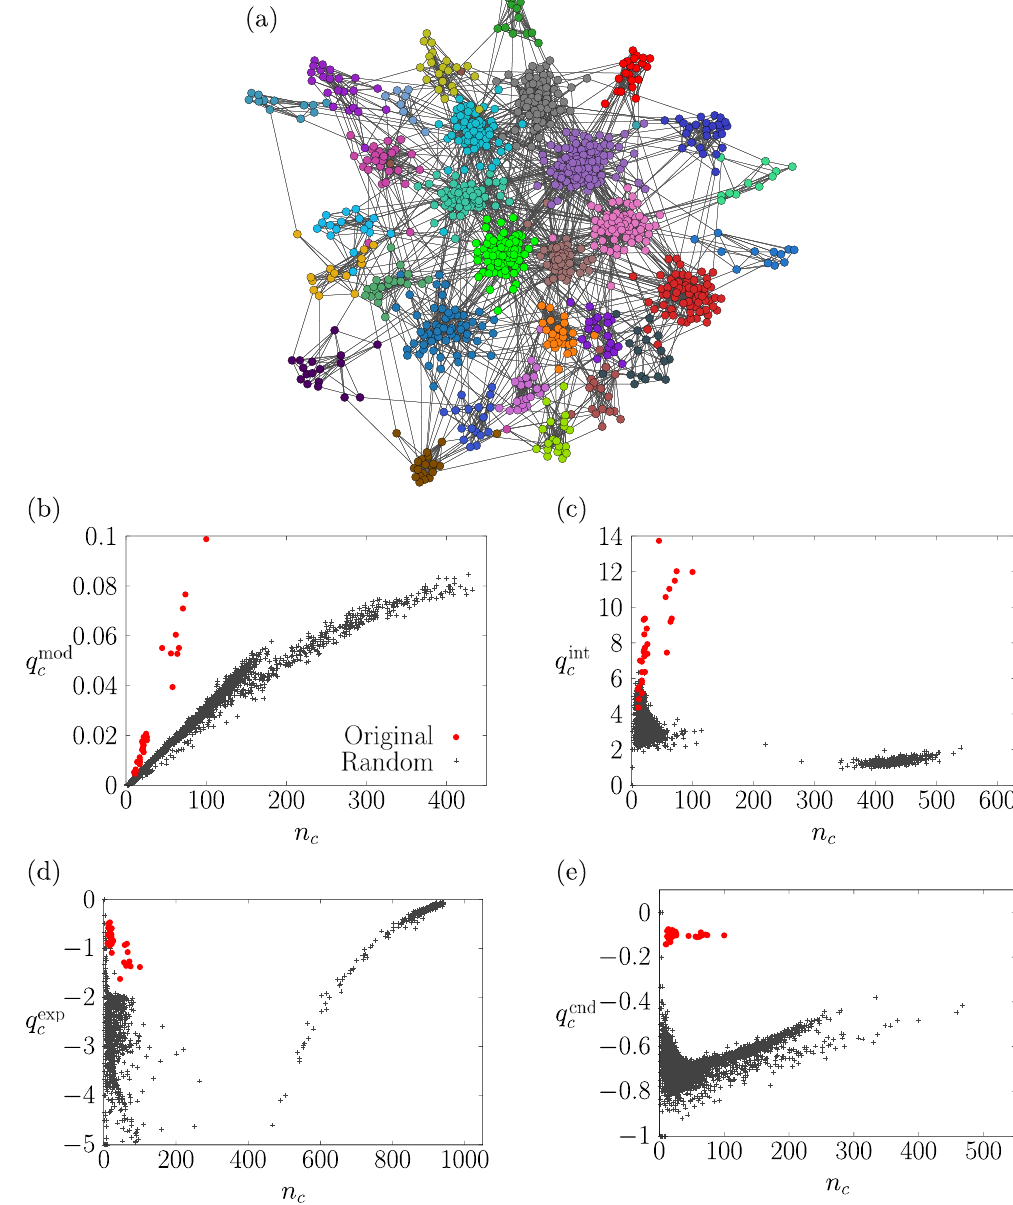
Figure 1. ( a ) A network with 31 non-overlapping communities generated by the LFR model. The circles represent nodes. The lines between the nodes represent edges. The colour of each node indicates the planted community to which the node belongs. ( b – e ) Quality of a community (i.e., q against its number of nodes, n c . The circles indicate the planted communities shown in panel (a). The crosses indicate the communities detected in 500 randomised networks generated by the configuration model. To find communities in the randomised networks, we use the Louvain algorithm 26 for q the Kernighan–Lin algorithm 27 for q